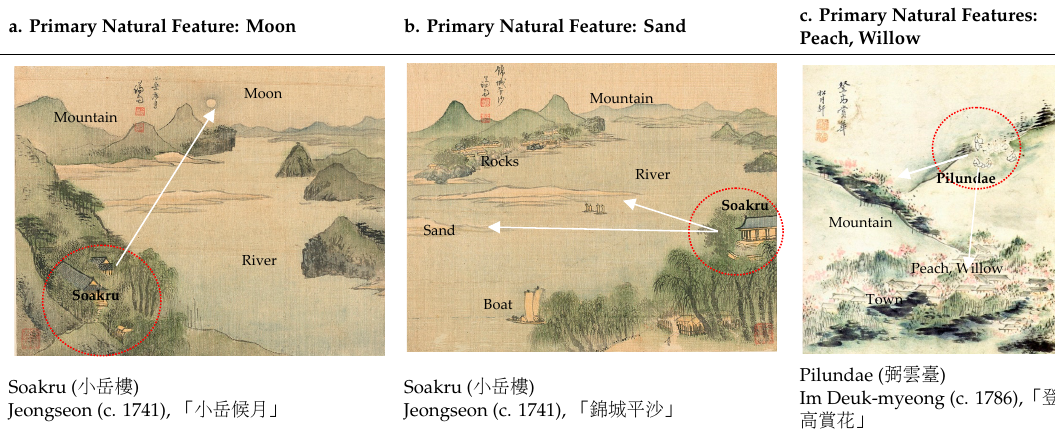
Table 2. Analysis examples of the noted natural places’ scenic characteristics.